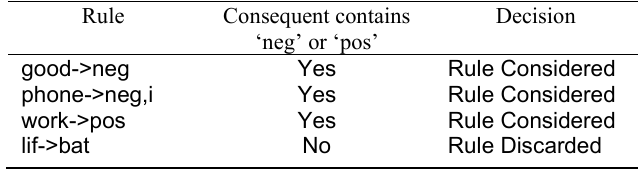
Figure 1. Proposed Feature Selection Technique using Apriori Algorithm Table 4. Association rules generated on Product Review Amazon Review